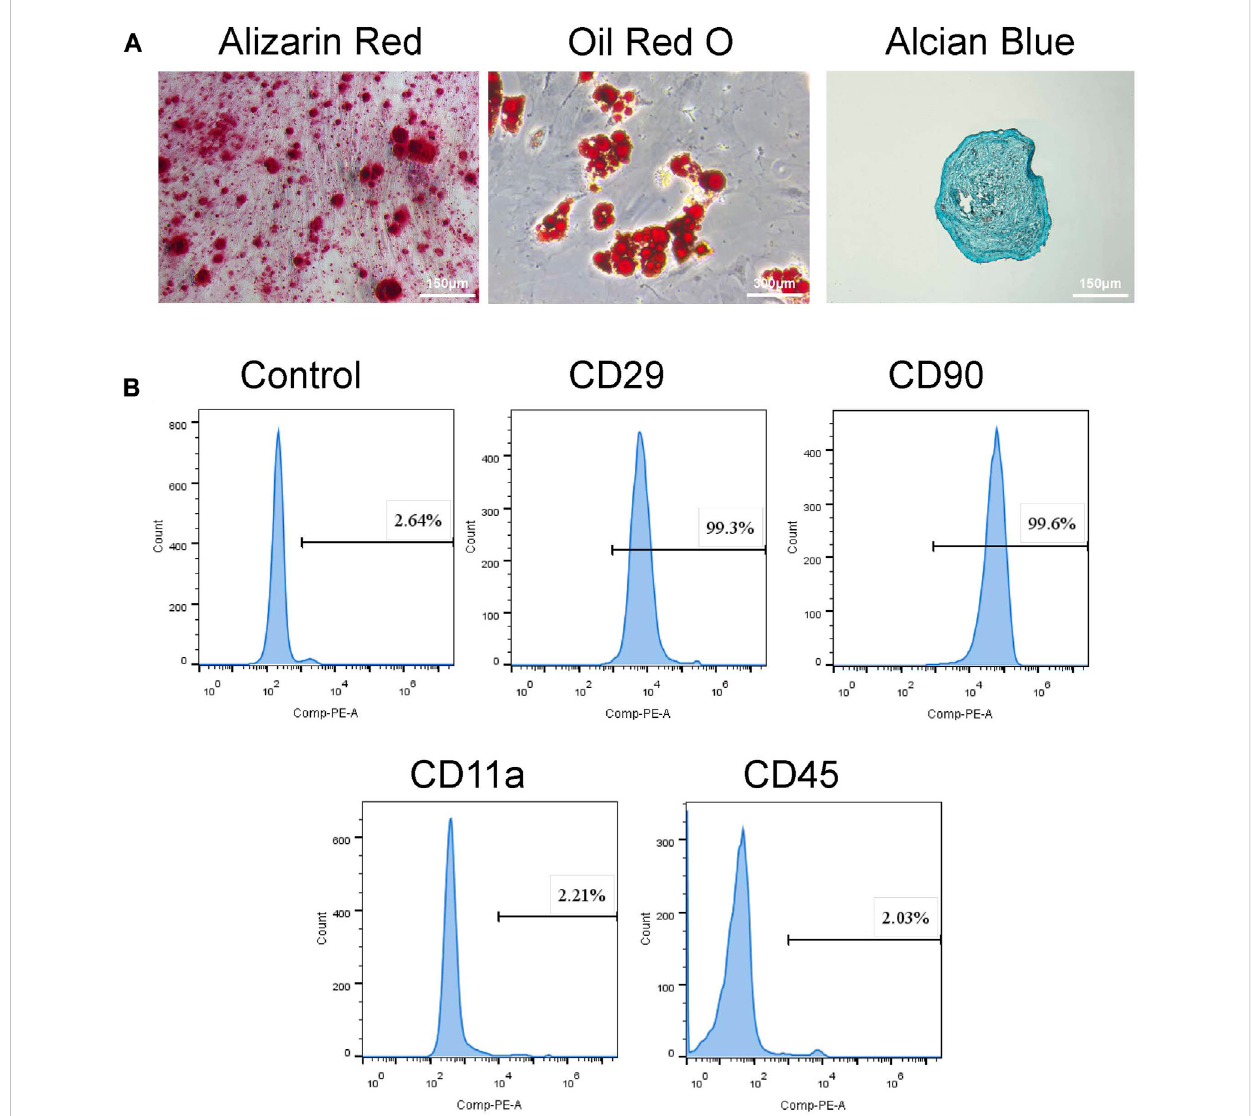
FIGURE 1 Identi fi cation of BMSCs. (A) Tri-lineage differentiation of BMSCs was performed in vitro . a. Alizarin red S staining of cells cultured for 14 days in osteogenic induction medium. b. Oil red O staining of cells cultured for 28 days in adipogenic induction medium. c. Alcian blue staining of cells cultured for 21 days in chondrogenic induction medium. (B) Flow cytometry demonstrated that BMSCs presented high expressions of CD29, CD90, but low expressed CD11a and